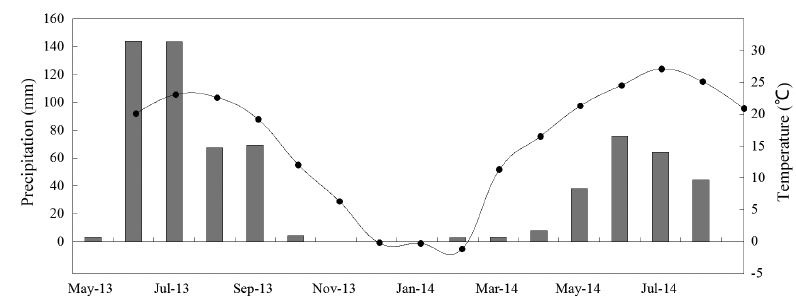
Figure 1. Monthly precipitation (bars) and average temperature (dots) during the experimental period.